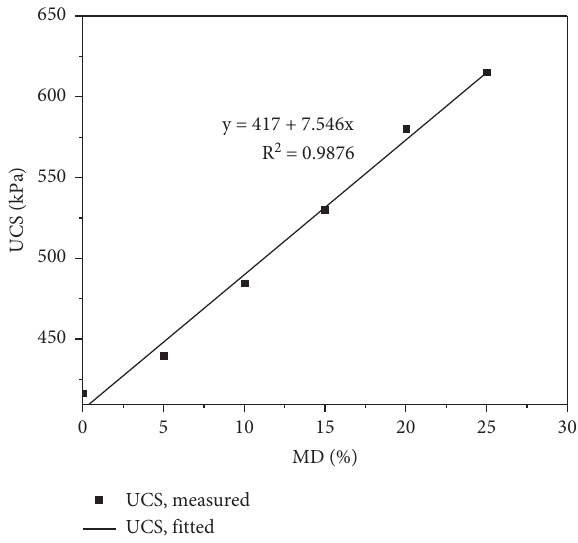
Figure 11: Variation of UCS with the percentage of